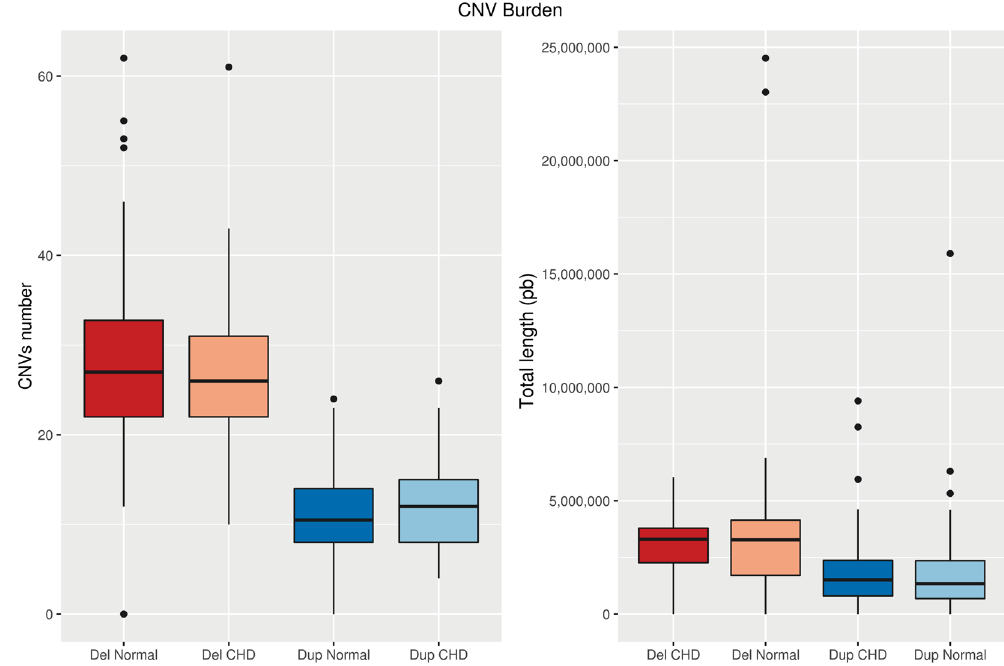
Figure 1. Total CNV burden in 22q11.2DS patients. Standard box-and-whiskers plot for the distribution of the total length and number of CNV (deletions and duplications) in CHD vs. no- CHD. Boxes represent the 1st and 3rd quartiles of each distribution, thick horizontal lines represent the median value, and circles represent